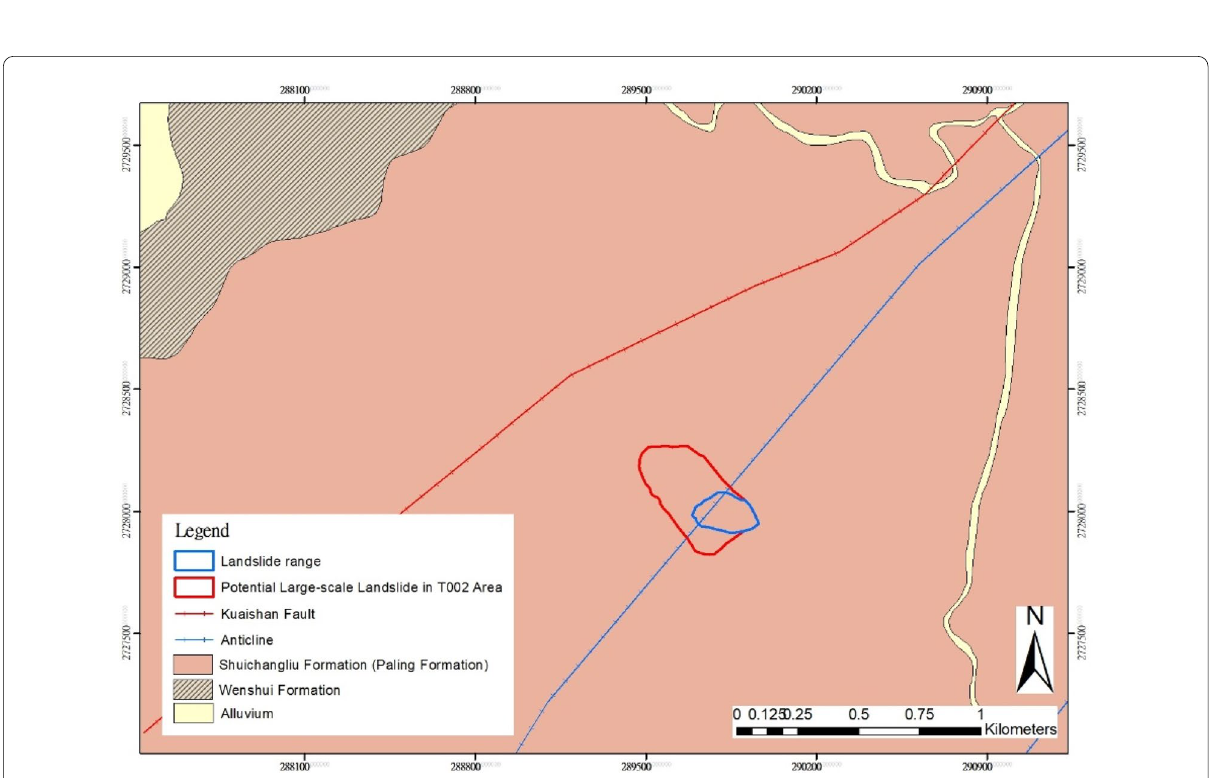
Fig. 4 Geology of the study